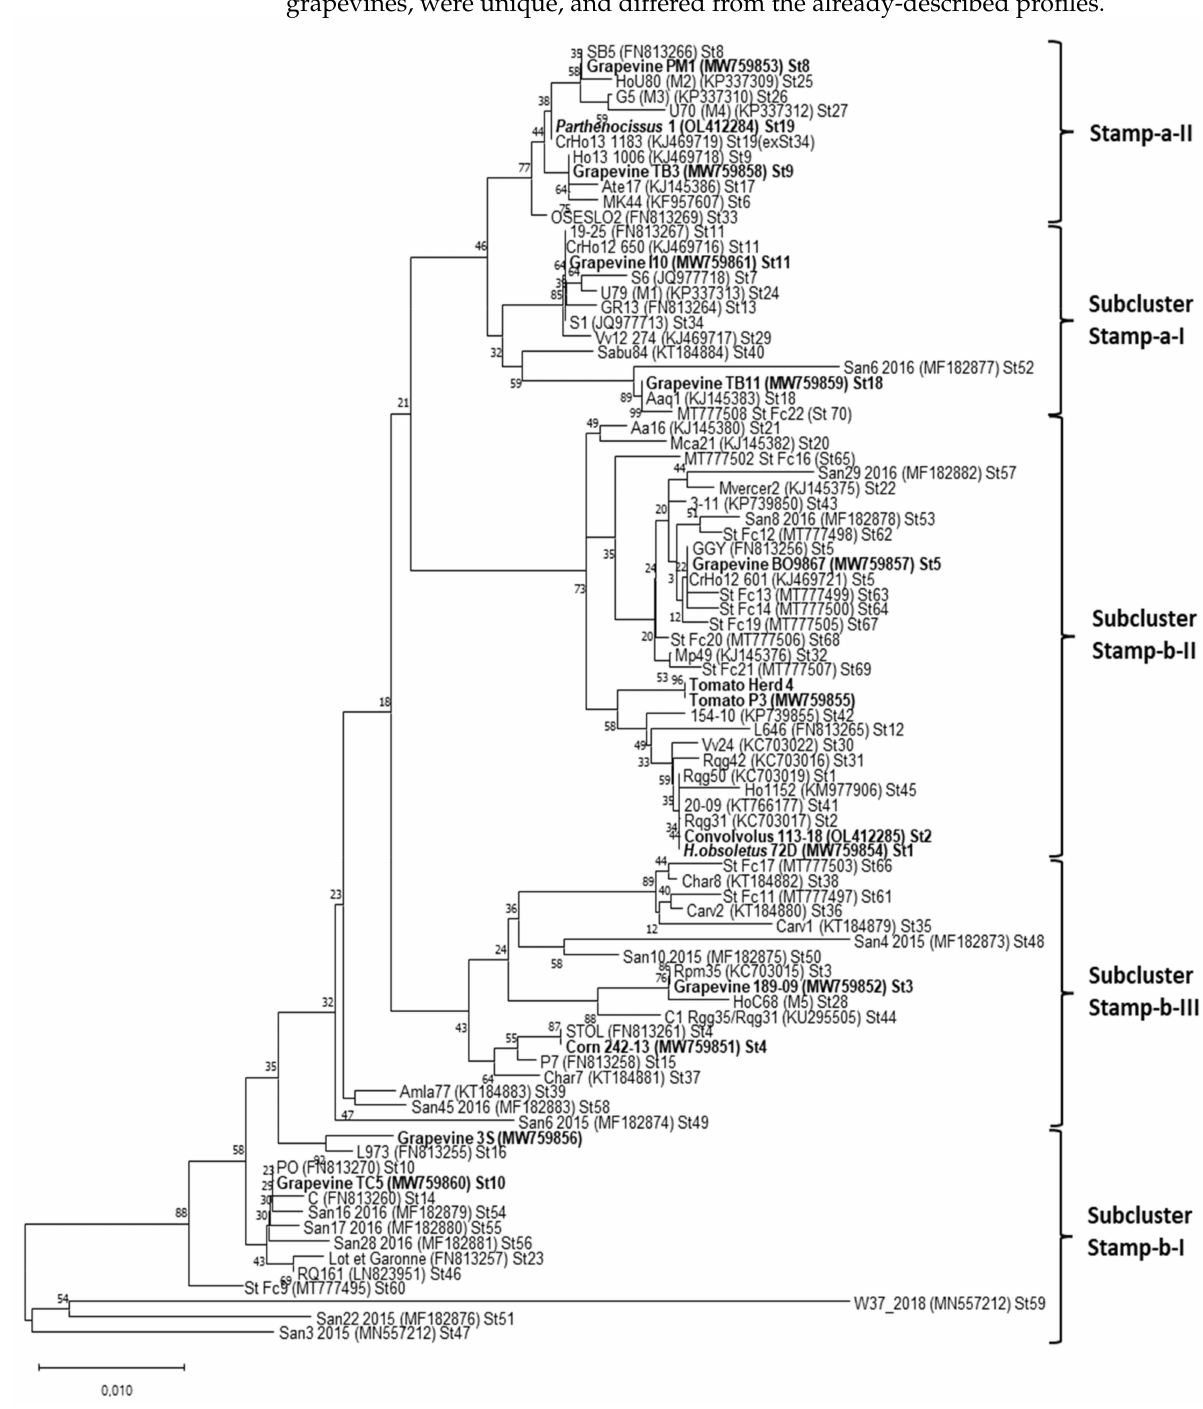
Figure 3. Unrooted phylogenetic tree inferred from stamp gene nucleotide sequences of ‘ Ca . P. solani’ strain representative of stamp sequence variants previously described [17,26,41,42] and identified in this work (Table 3). Phylogenetic analysis was carried out using the neighbor-joining method and bootstrap-replicated 1000 times. Phytoplasma strains included in the phylogenetic analysis are given in the tree image. The GenBank accession number of each sequence is given in parentheses; gene sequences obtained in the present study are indicated in bold. Clusters are shown on the